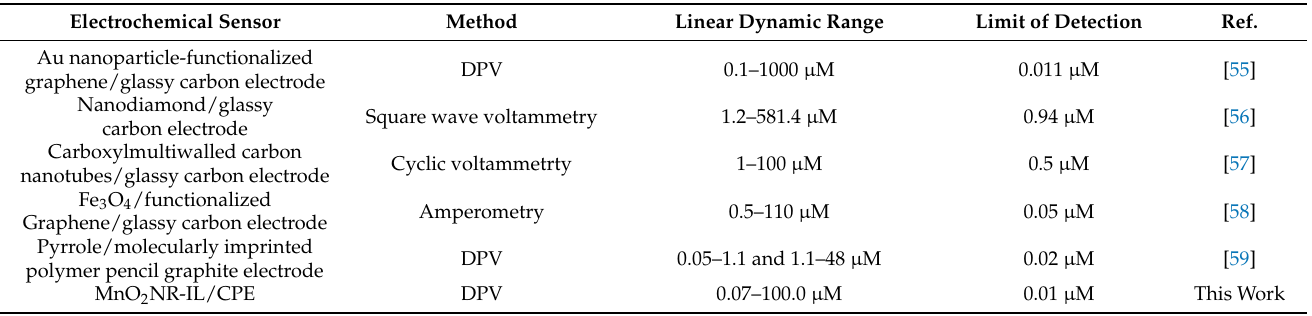
Table 1. Comparison of the linear range and detection limit obtained for MnO 2 NR-IL/CPE with the determination of SAA with other